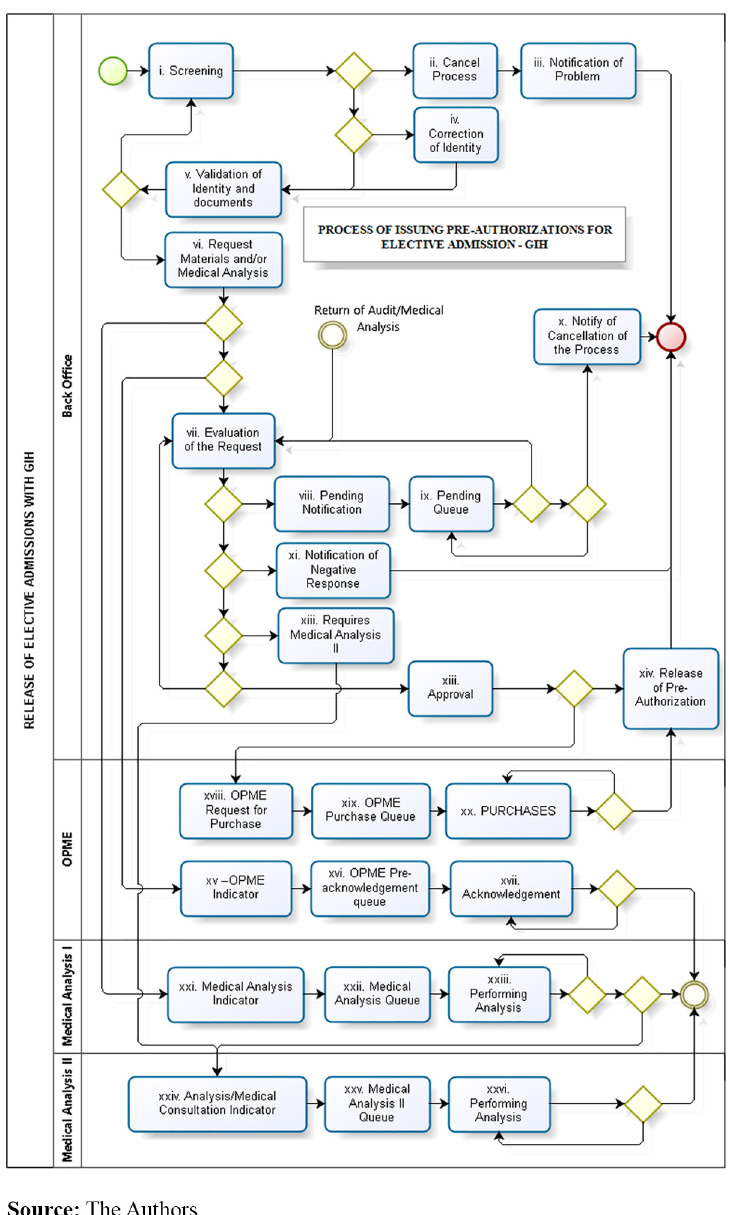
Figure 2. Example of the fl ow of release of